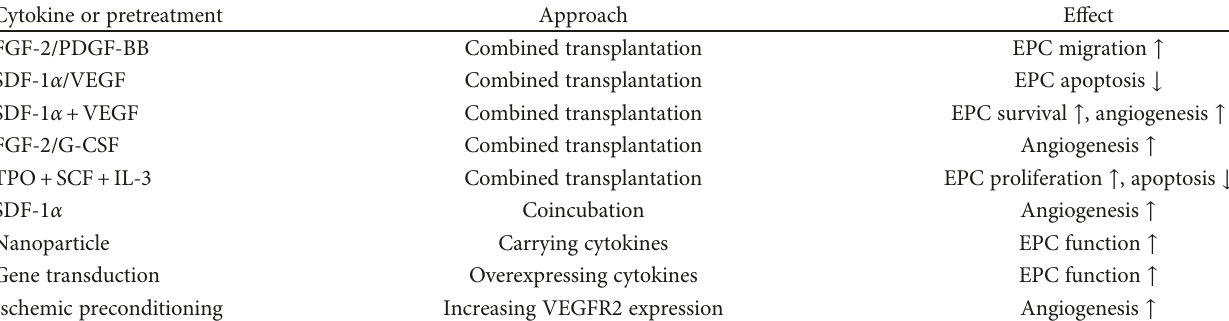
Table 2: Combination of EPCs and cytokines or